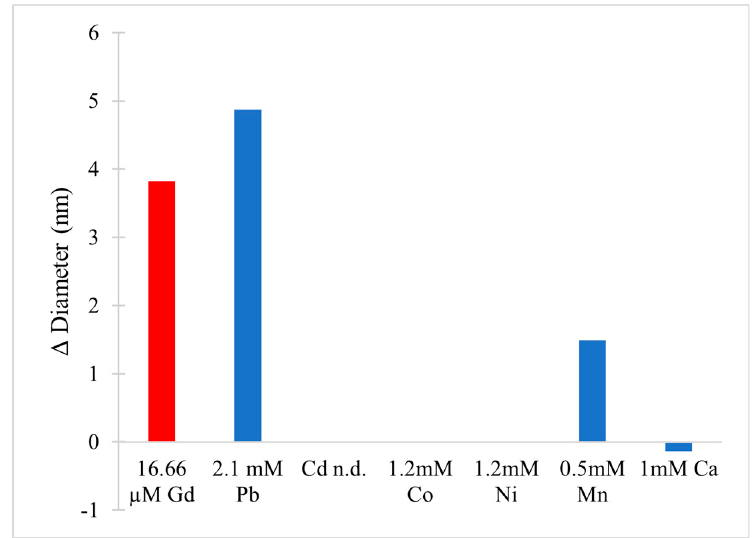
Figure 13. Change in size of brain SM liposomes in the presence of various heavy metals. Measured by DLS. by DLS.